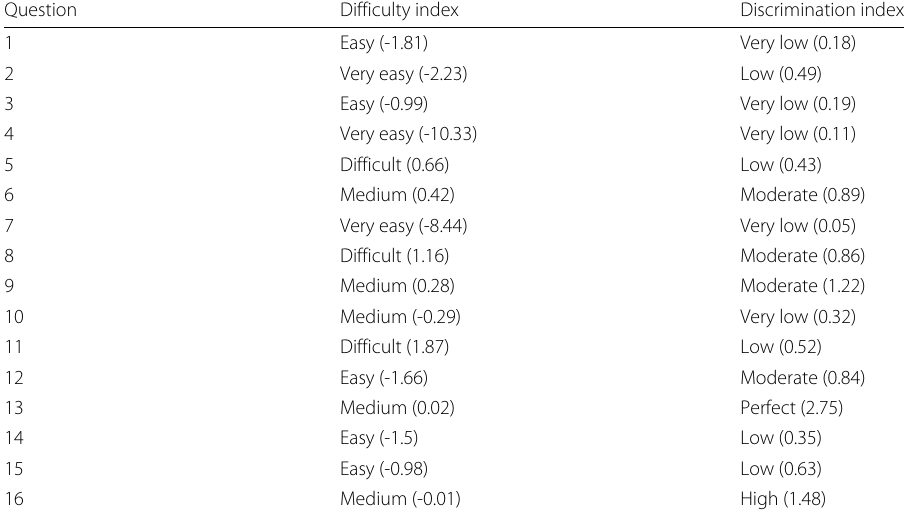
Table 20 Questions’ difficulty and discrimination indices using IRT